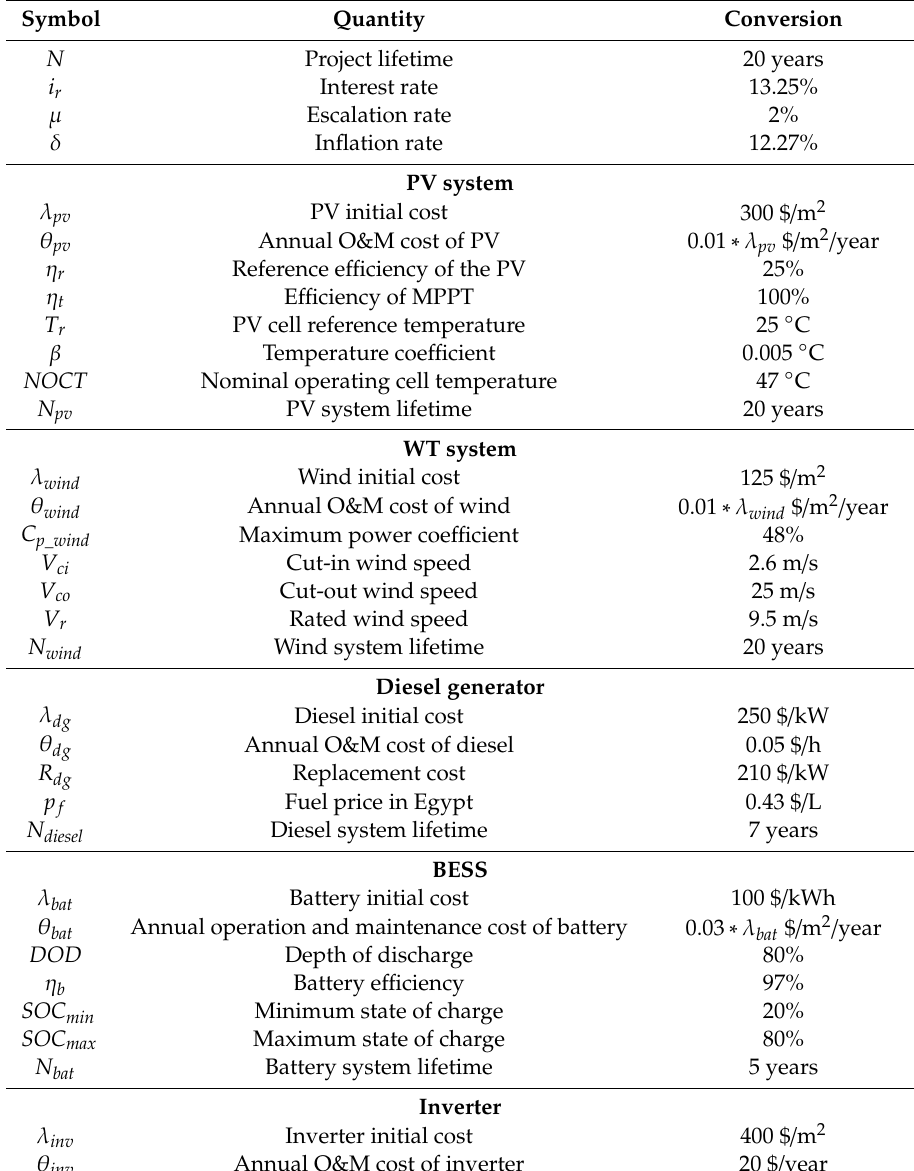
Table 1. Units for magnetic